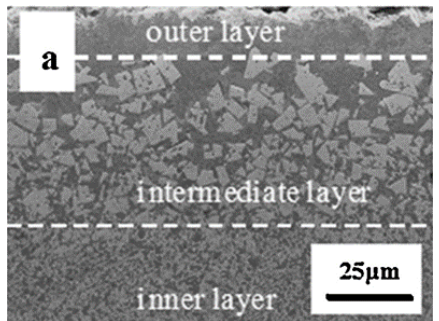
Figure 13. Cross-section SEM image of the surface of a graded cemented carbide material obtained in [202].